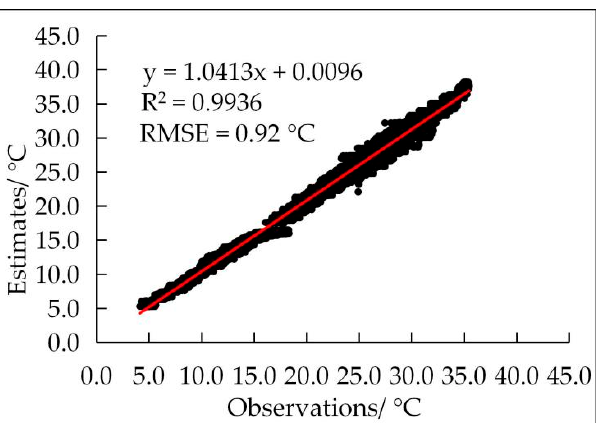
Figure A6. After reducing 16 temperature sensors, the linear fitting results between the observed and simulated values are reduced by B, C, D, and E columns.